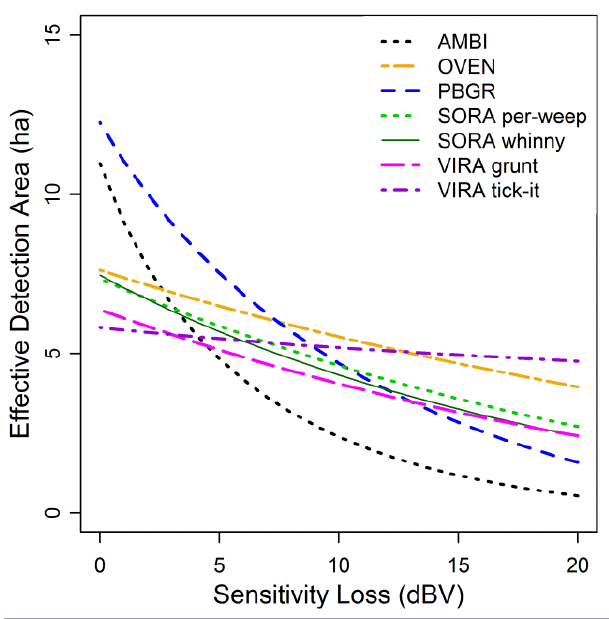
Fig. 6 . Effective detection area (ha) of American Bittern (AMBI), Ovenbird (OVEN), Pied-billed Grebe (PBGR), Sora (SORA) per-weep and whinny calls, and Virginia Rail (VIRA) grunt and tick-it calls during Beaufort 2 noise conditions (42 dBA) for increasing degrees of microphone sensitivity loss